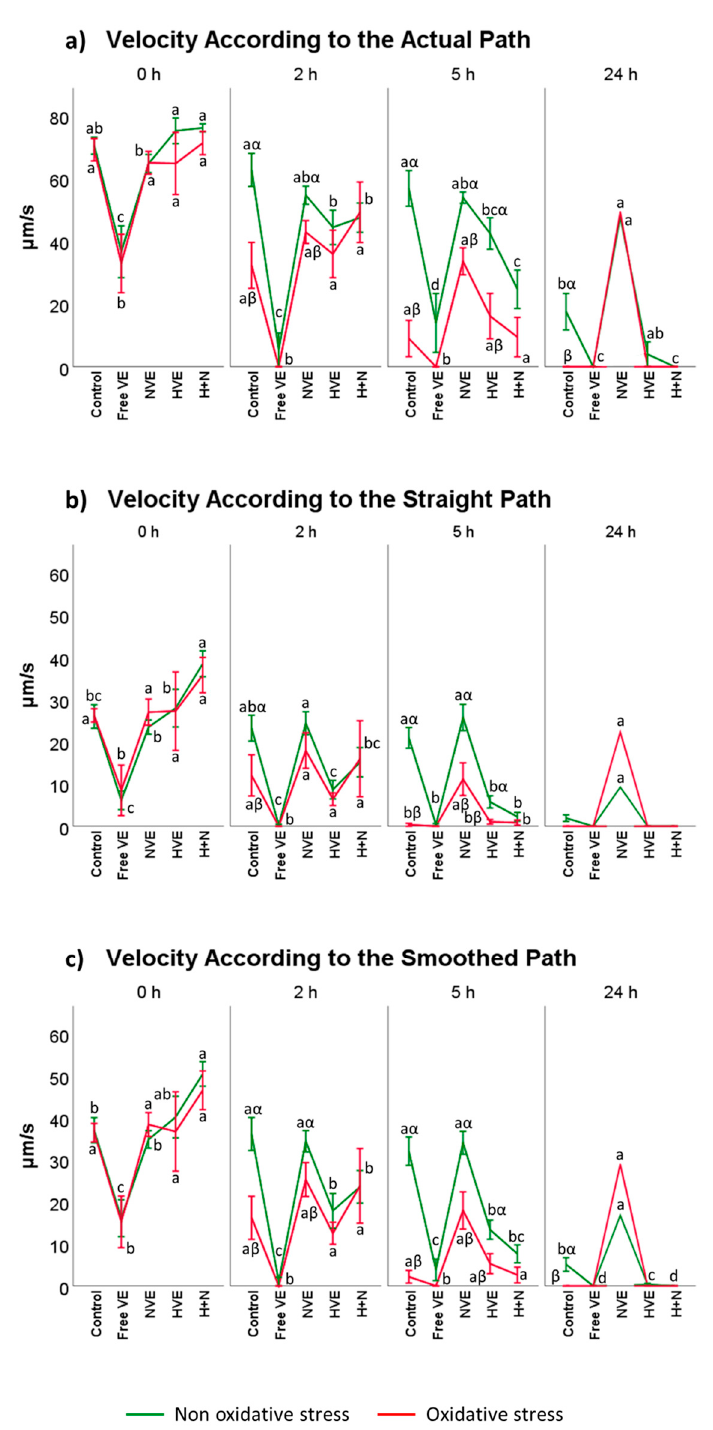
Figure 5. Vitamin E formulation effects on sperm velocity parameters. Plots ( a – c ) represent the triple interaction of different vitamin E treatments × oxidative treatment × incubation time for CASA-derived variables. The various lowercase Latin letters ( p < 0.05) indicate significant differences between vitamin E treatments, while the different Greek letters ( p < 0.05) compare each treatment at the same time with a different oxidative stress status.